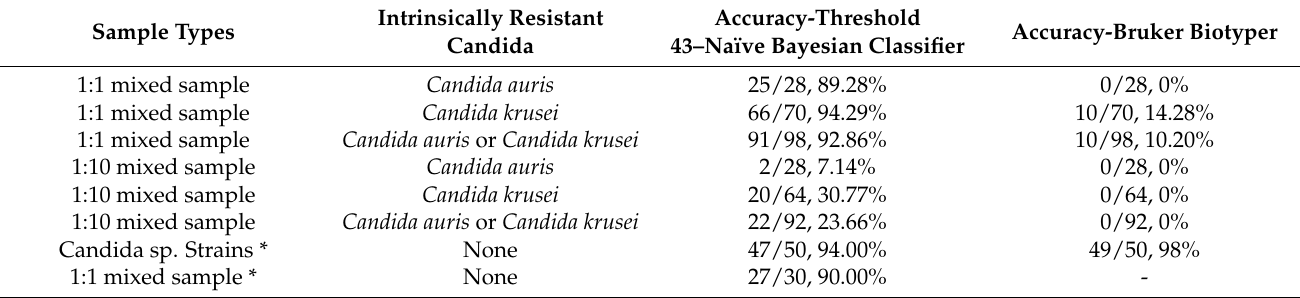
Table 2. Identification results obtained with the modified naïve Bayesian classifier and Bruker Biotyper. Sample Types